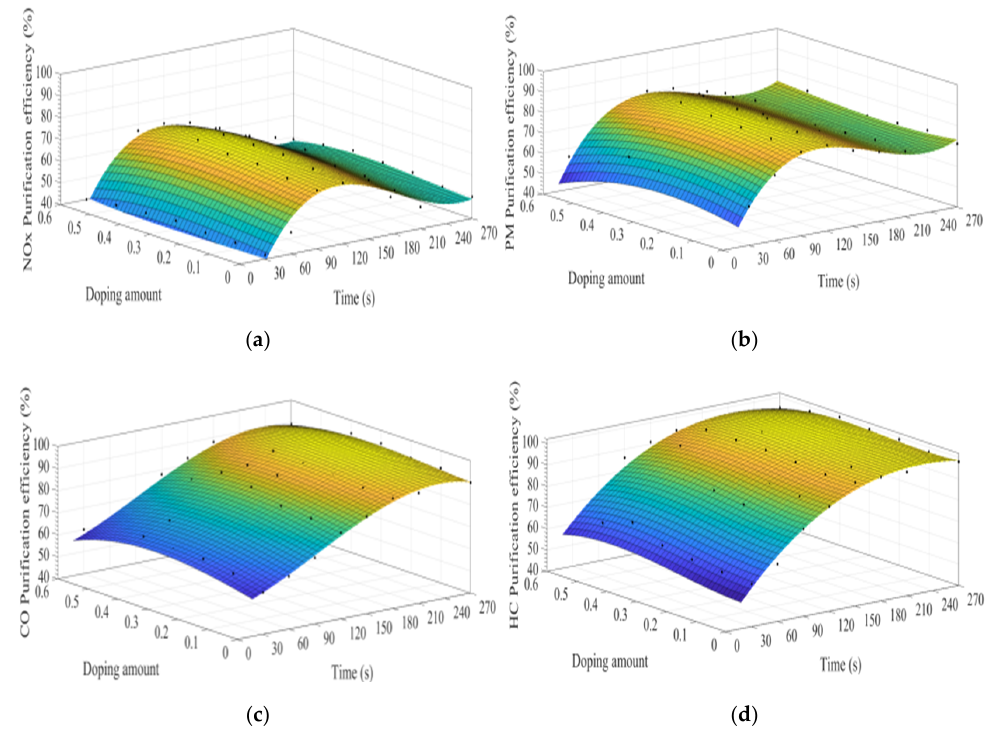
Figure 8. Purification efficiency curve of catalyst when A site was doped with calcium ions: ( a ) NO x ; ( b ) PM; ( c ) CO; and ( d ) HC.